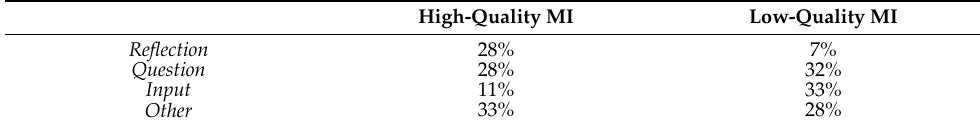
Table 11. (Main) Behaviour distributions in high- and low-quality MI.